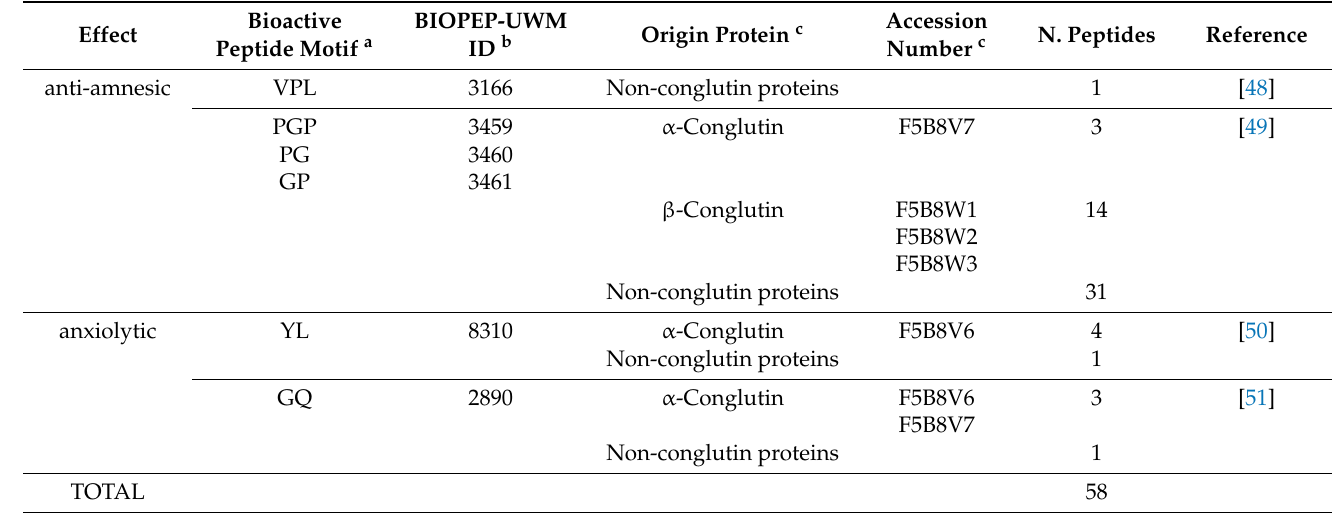
Table 2. The number of identified LPH peptides with anti-amnesic and anxiolytic